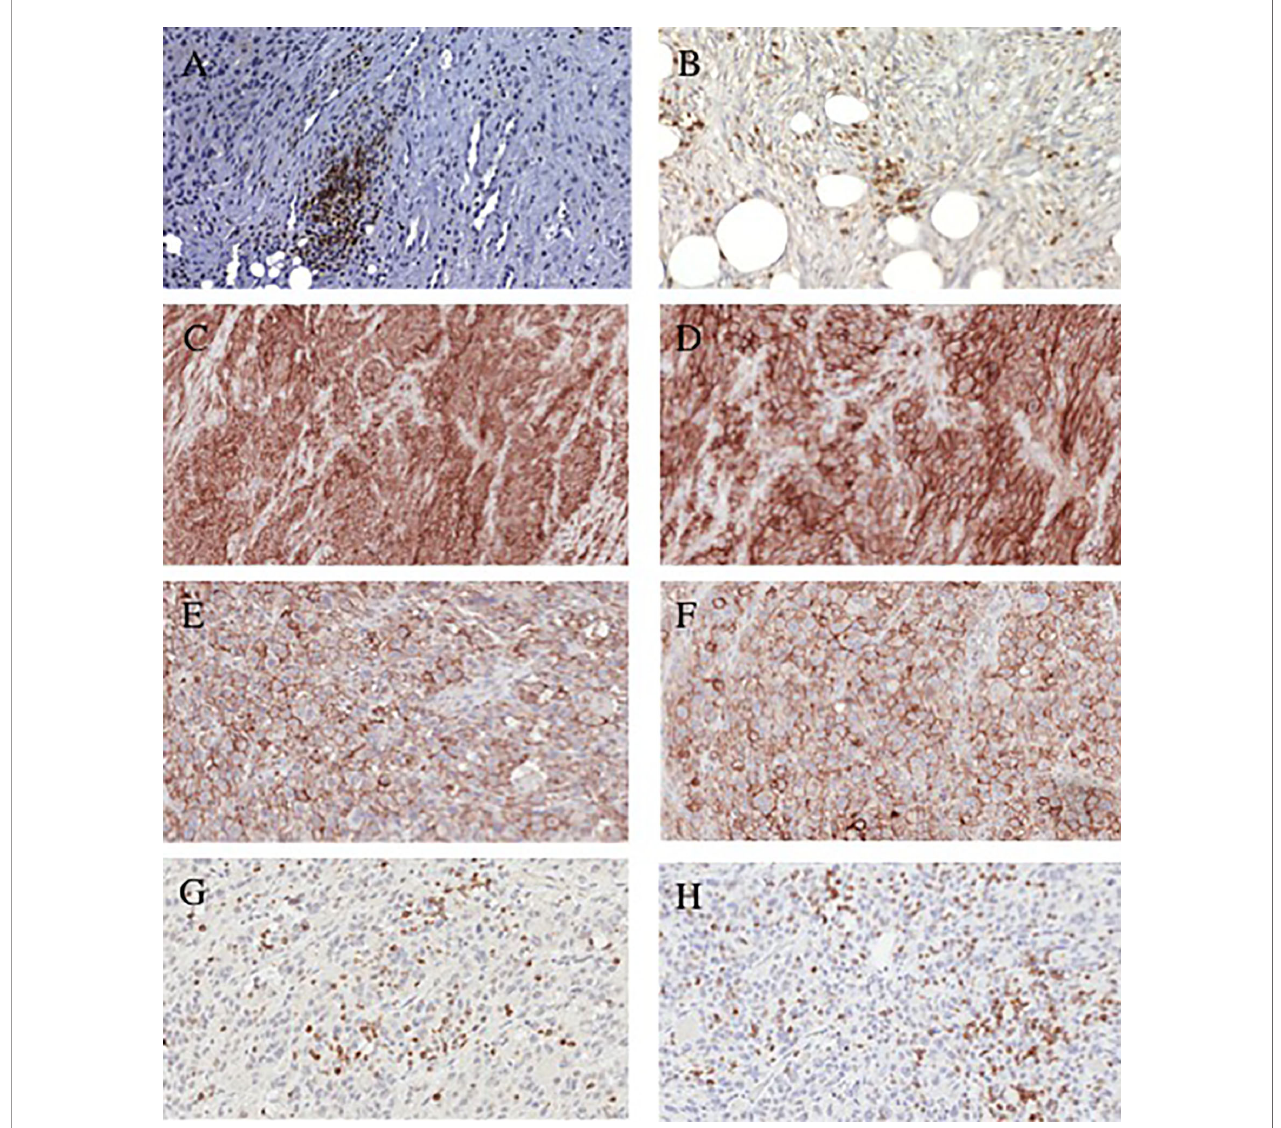
FIGURE 1 | Representative immonohistochemical staining patterns of dedifferentiated chondrosarcoma tumors with lymphocyte and checkpoint-speci fi c monoclonal antibodies. (A) CD4 + TILs (200x magni fi cation). (B) CD8 + TILs (200x magni fi cation). (C) PD-L1 positive cells (100x magni fi cation). (D) PD-L1 positive cells (200x magni fi cation). (E) PD-L1 positive cells (200x magni fi cation). (F) ; PD-L1 positive cells (200x magni fi cation). (G) PD-1 positive lymphocytes (200x magni fi cation). (H) PD-1 positive lymphocytes (200x magni fi